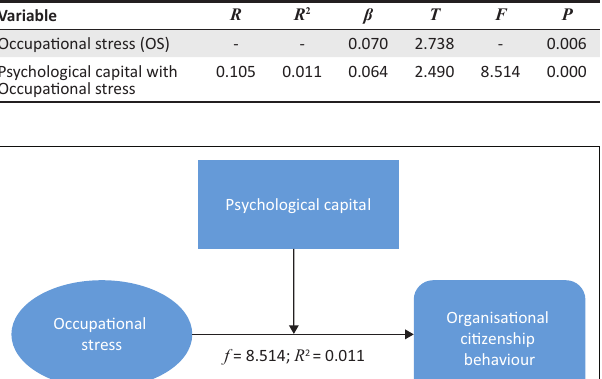
TABLE 3: Summary of multiple regression analysis showing the moderating role of psychological capital in the relationship between occupational stress and organisational citizenship behaviour.